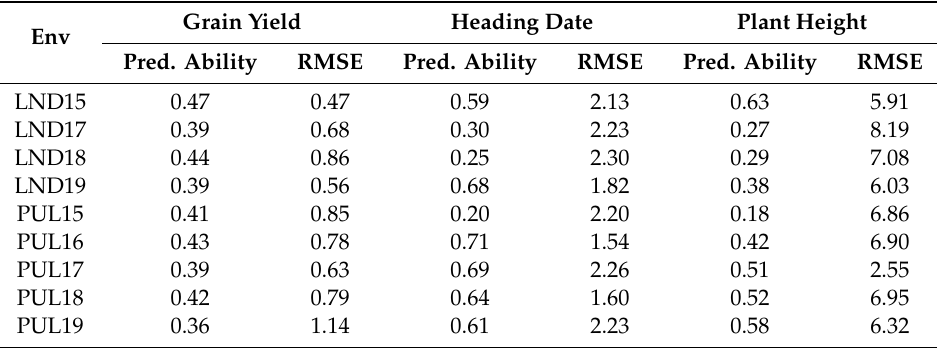
Table 6. Predictive ability for grain yield, heading date, and plant height using a genomic BLUP (GBLUP) model across di ff erent environments. Grain Yield Heading Date Plant Env